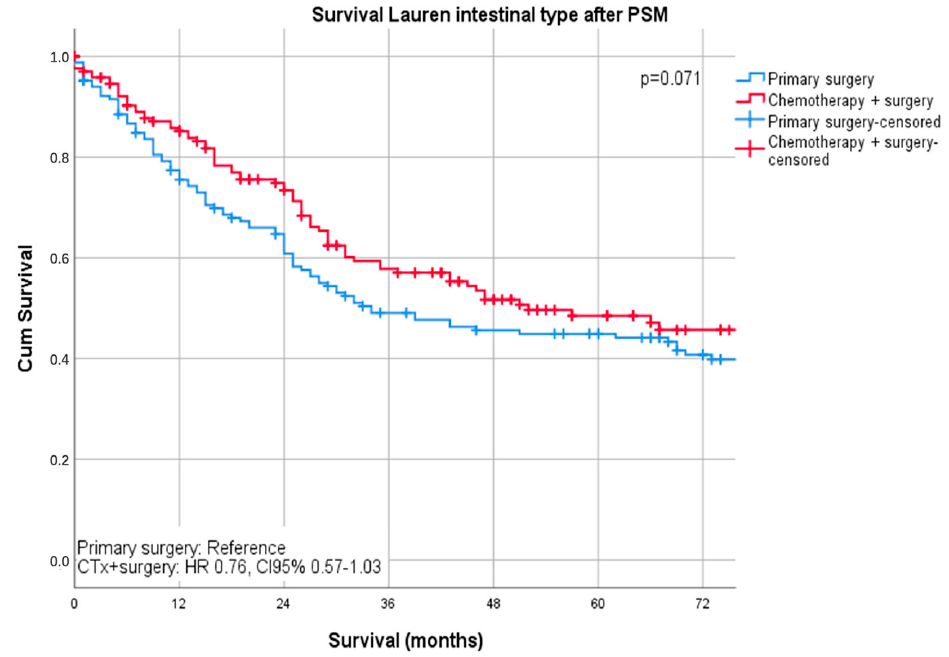
Figure 1. Survival curves for Lauren intestinal subtype after PSM stratified by surgery only vs. chemotherapy plus